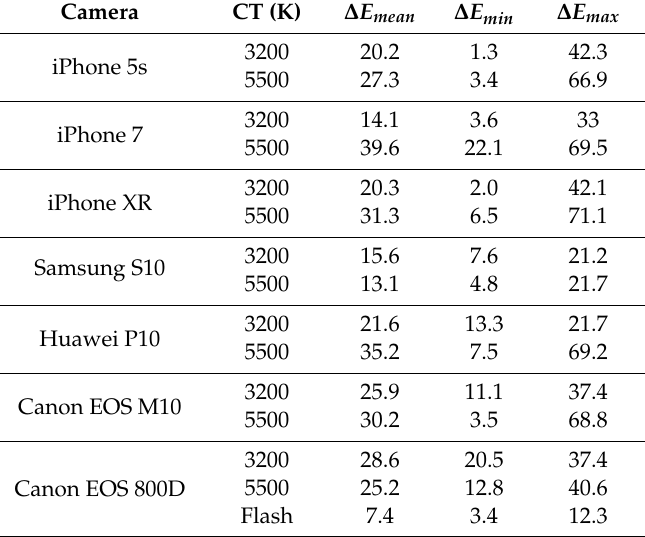
Table 4. Colour accuracy is given with colour distances as mean value ∆ E mean , minimum ∆ E min and maximum ∆ E max , calculated on 16 colours from the test